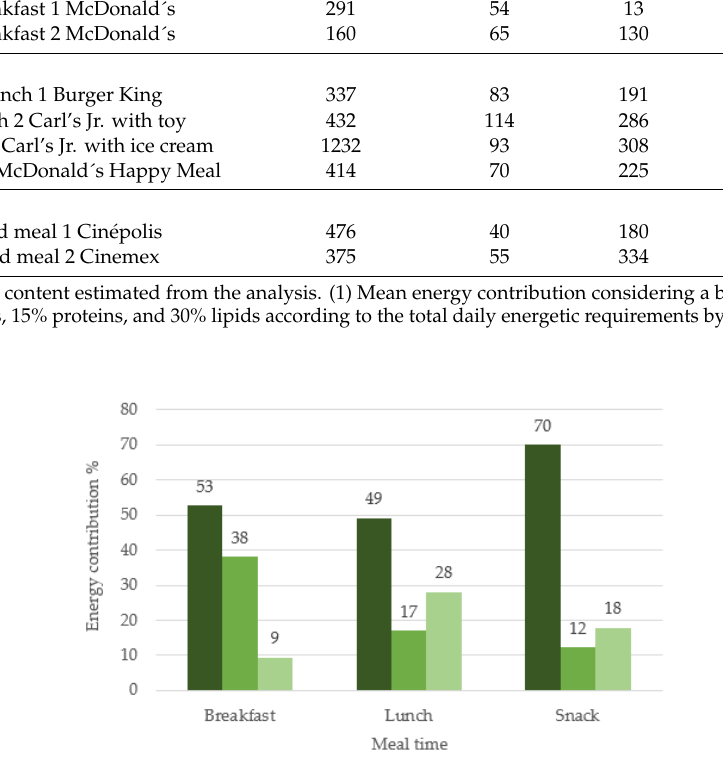
Table 2. Bromatological results for energy and macronutrient content of kids' meals.